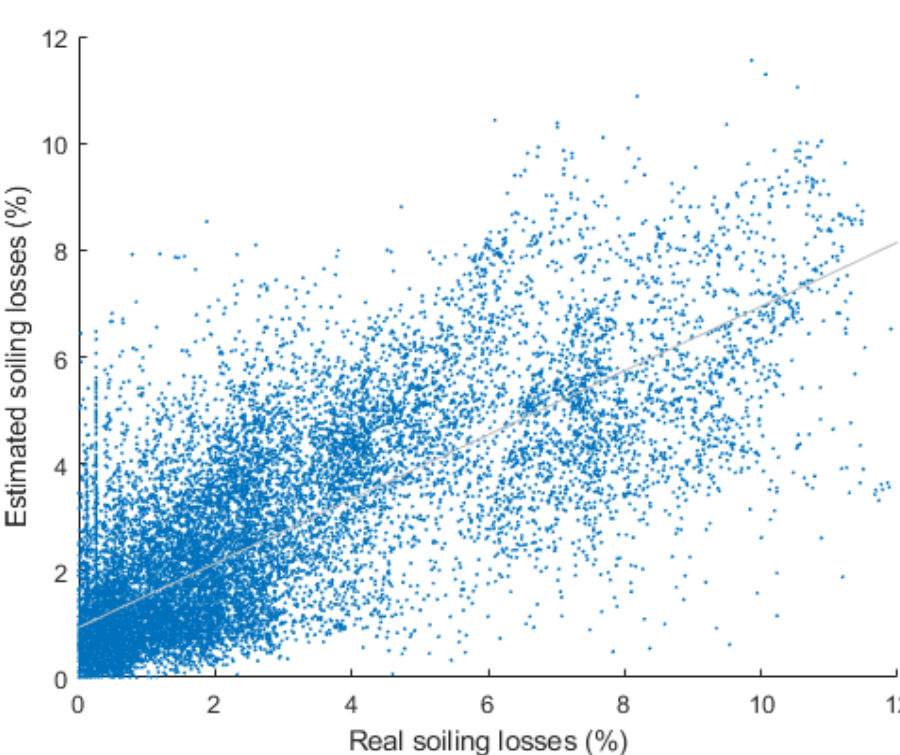
Figure 9. Scatter plot of actual vs. estimated losses without Isc.